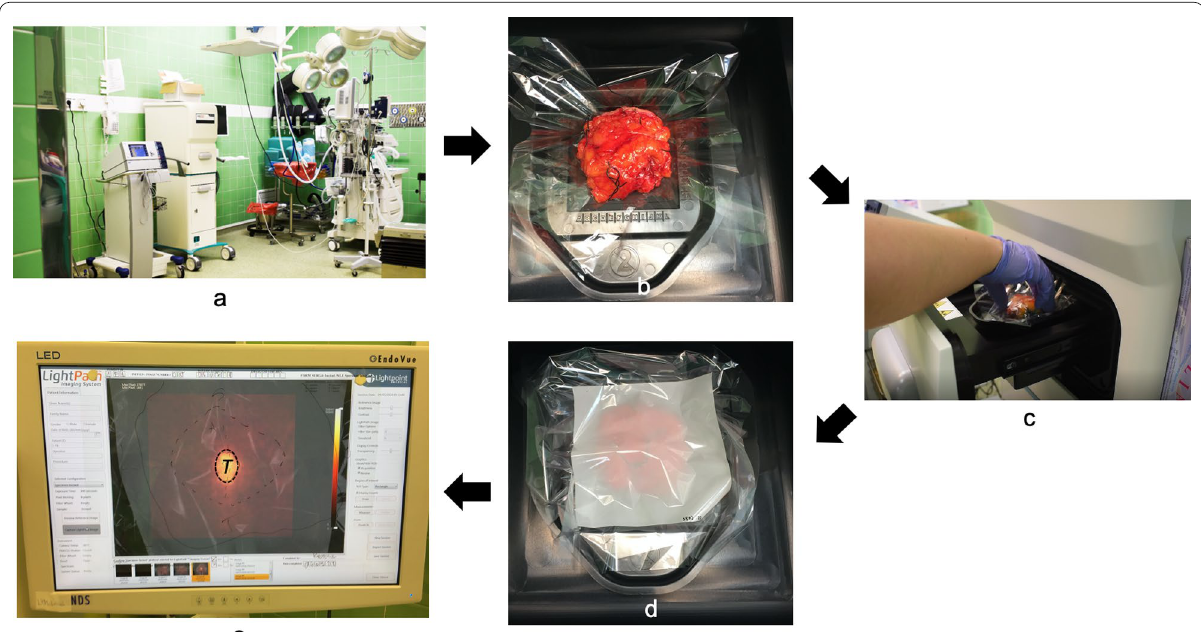
Fig. 2 Workflow of intraoperative FAR imaging. a The LightPath ® Imaging System was located within the operating theatre. b Immediately following dissection, the intact WLE specimen was placed in a disposable specimen tray. c The specimen tray and specimen were loaded into the light‑tight specimen chamber, and a photographic reference image was acquired to confirm that the specimen was correctly positioned. The specimen contours were drawn on a transparent CRF, and each tumour margin was annotated (not shown). d A 5 μm Mylar separator sheet and a flexible scintillator film were draped over the specimen, and a FAR image was acquired. (e) FAR image of WLE specimen shows elevated tumour radiance. The transparent CRF attached to the LightPath ® monitor shows the specimen contours, tumour margin borders, the incision line and the location of the primary tumour (T) in the area of the elevated